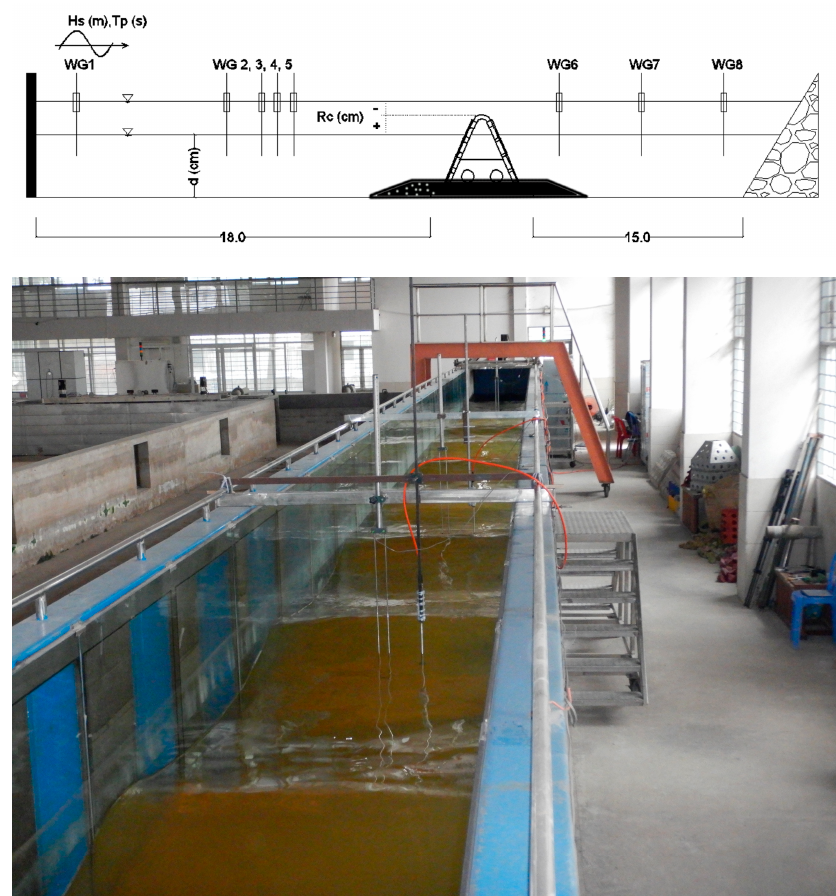
Figure 7. Wave flume in the Coastal Hydrodynamics Laboratory of SIWRR.